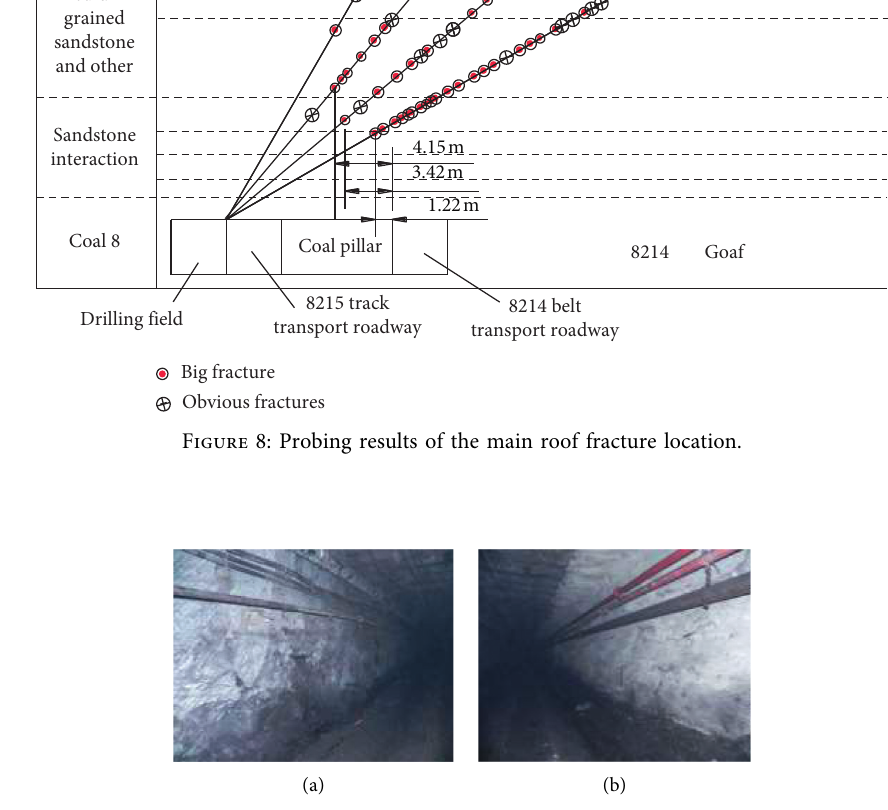
Figure 9: Surrounding rock control effect of the 8215 rail transportation roadway ten months late after driving. (a) Mining side. (b) Coal pillar side.